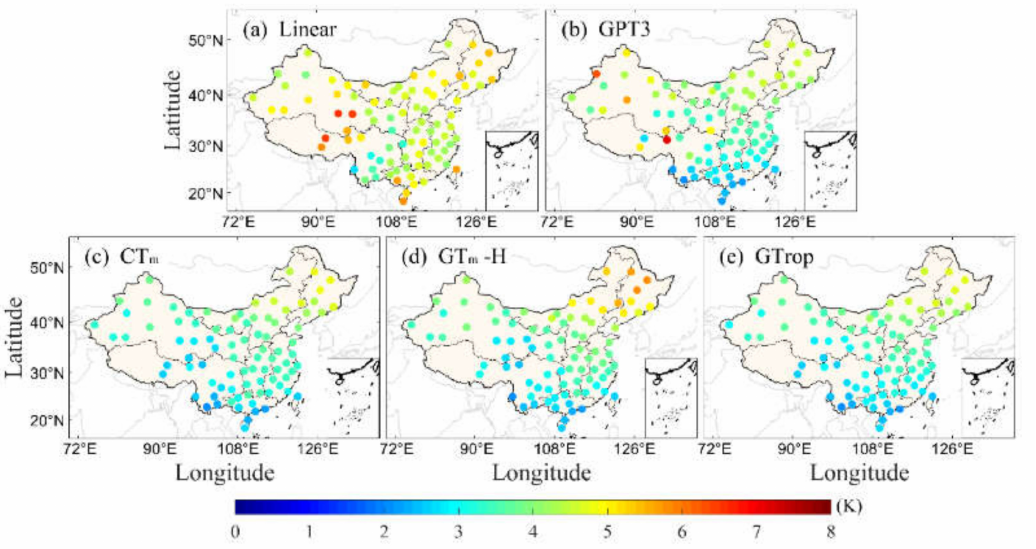
Figure 8. RMS distribution of the T m difference between the five T m models and the 87 RS stations in China over the period of 2011 to 2020.